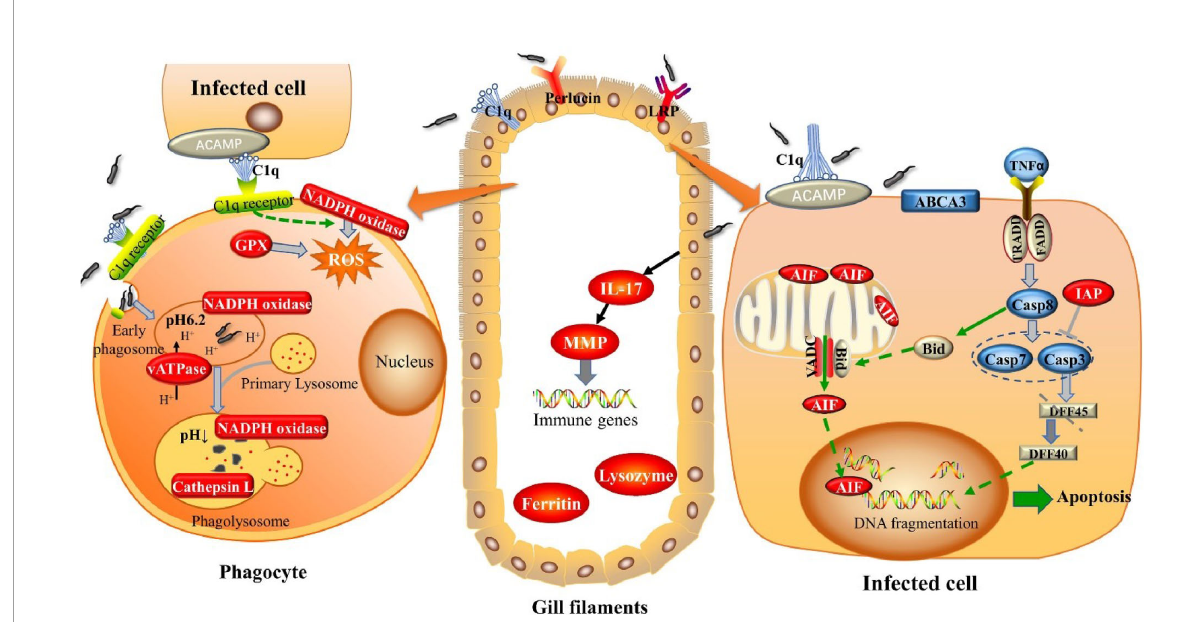
FIGURE 6 Graphic representation of the immune response in gill of abalone against Vibrio Parahemolyticus invasion.